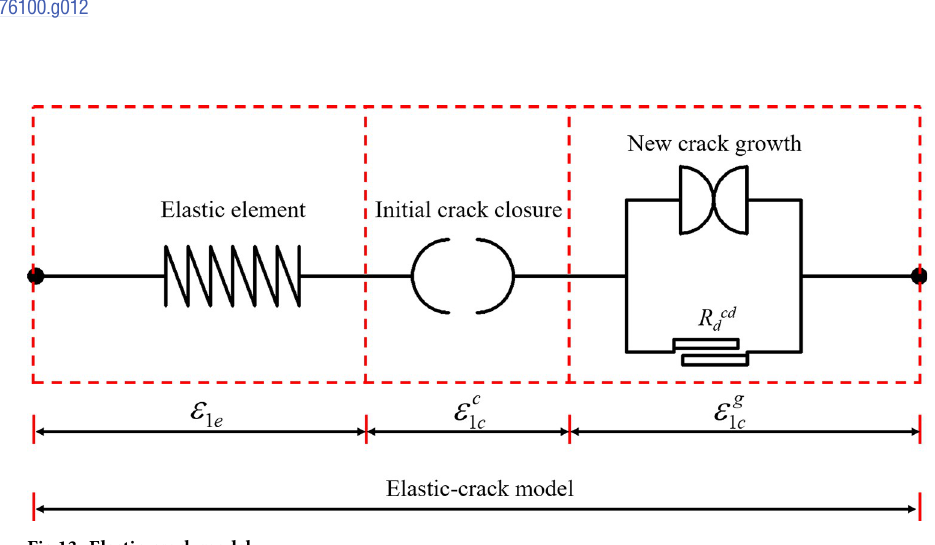
Fig 13. Elastic-crack model.